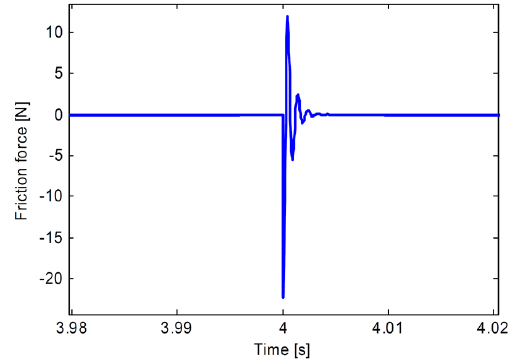
Figure 19. Friction predicted using LuGre